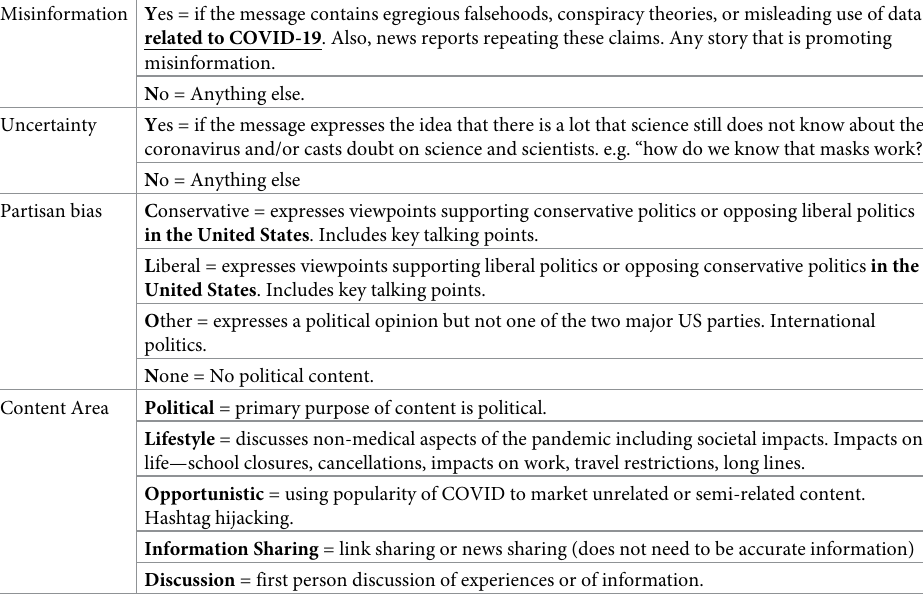
Table 1. Codebook for qualitative